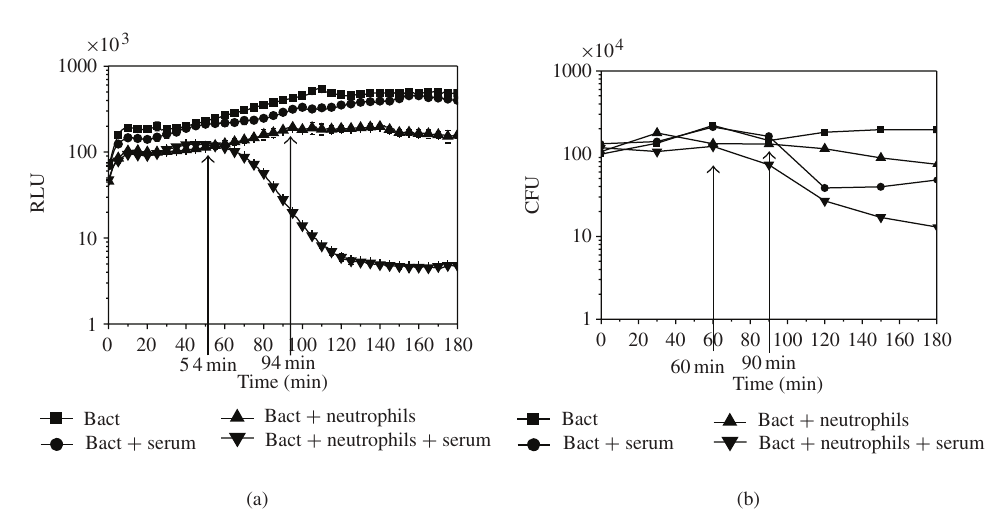
FIGURE 3: The bioluminescence signal (a) and colony forming units (CFU)/250 µ L (b) of E. coli -lux (1 × 10 6 cells) incubated in the presence of 2.5 × 10 5 neutrophils and 0.4 % serum for opsonization in gHBSS medium at 37 ◦ C: ( (cid:2) ) bacteria, ( • ) bacteria + serum, ( (cid:6) ) bacteria + neutrophils and ( (cid:3) ) bacteria + neutrophils + serum. Relative luminescence unit (RLU) values are shown as the mean ± S.D. of measurements from three parallel wells. Arrows point out the onset of the